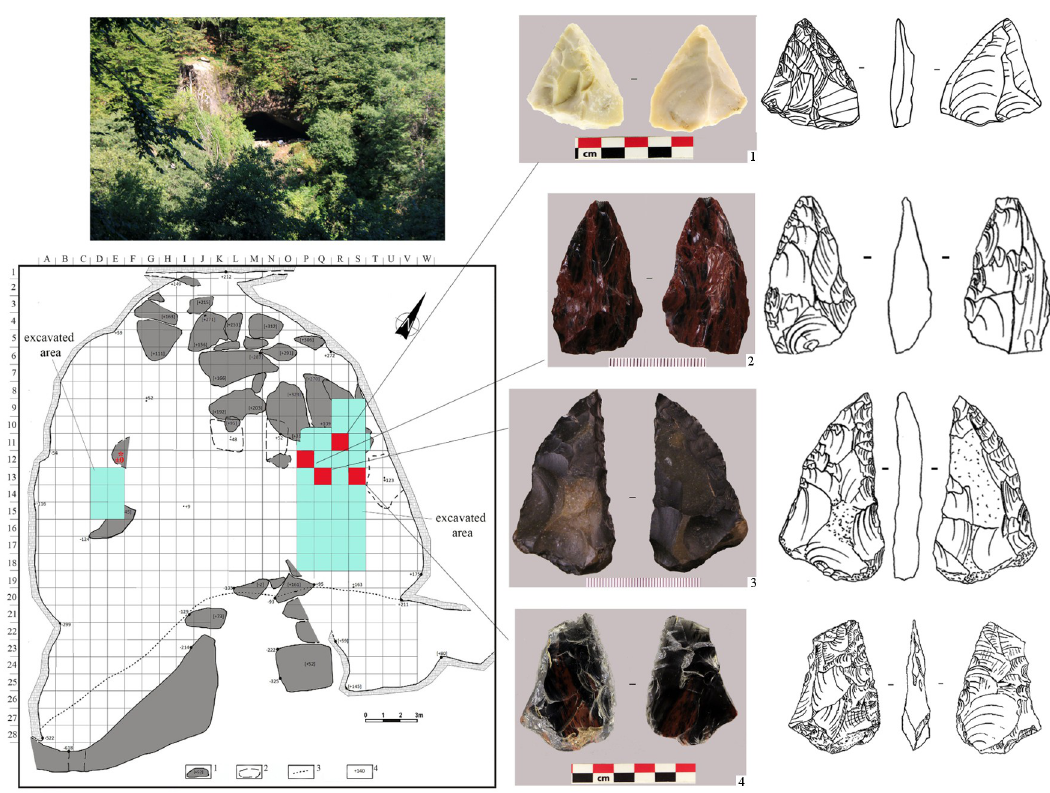
Fig 9. Saradj-Chuko grotto. Photo of the grotto, and plan of excavation showing the discovery points of artefacts typical of the Eastern Micoquian industry in Layer 6B. 1 –bifacial small handaxe; 2 –bifacial leaf point; 3, 4 –bifacial scraper-knives.